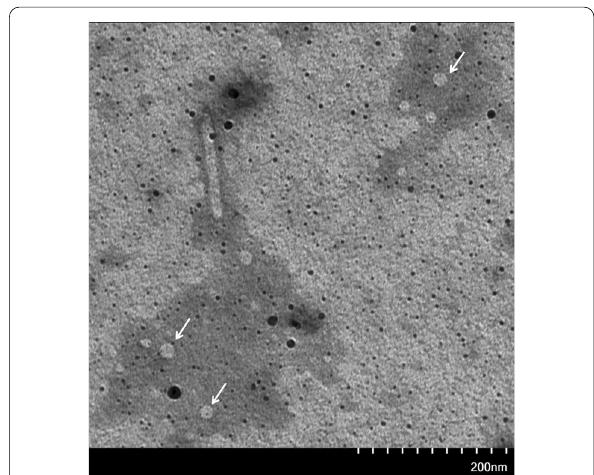
Fig. 5 Transmission electron micrographs of ΔCAP. Virus-like particles (VLPs) formed by purified ΔCAP proteins expressed in E. coli cells were viewed using an HT7700 operating at 120